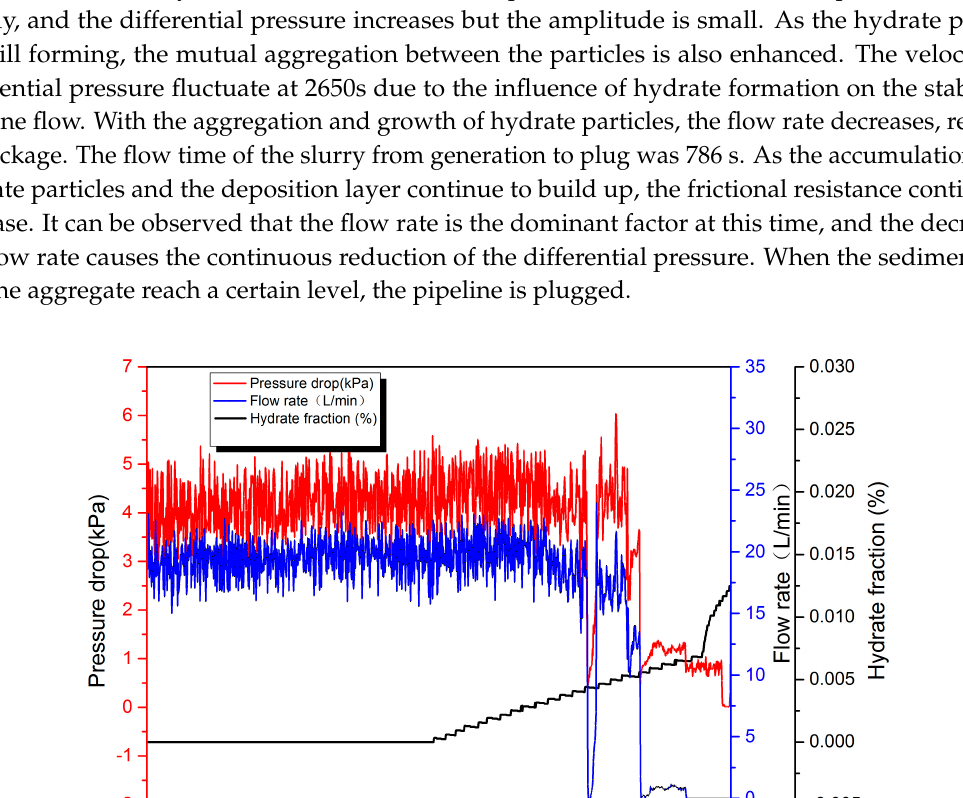
Figure 8. Variation of frictional resistance coefficient in pipelines with different water cut.